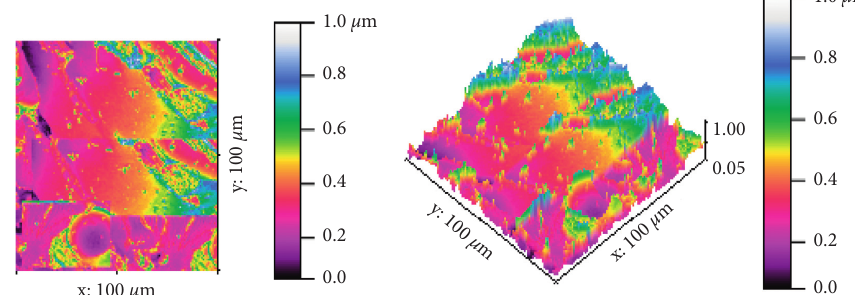
Figure 26: 2D and 3D profilometric image of the flexural test specimen.